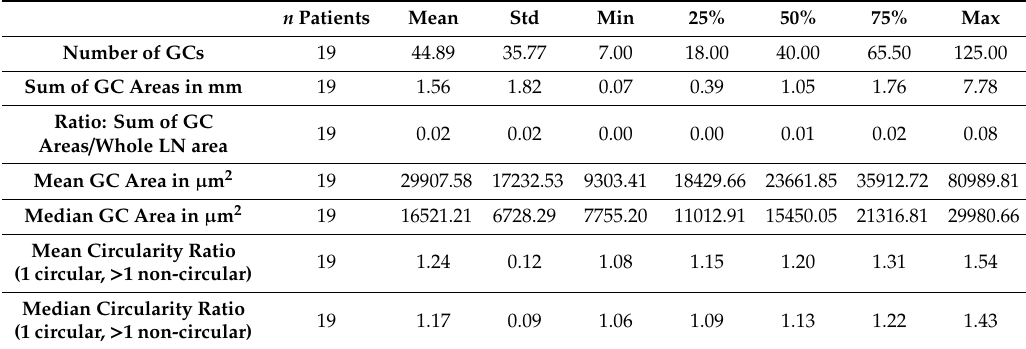
Table 3. Descriptive statistics of GC